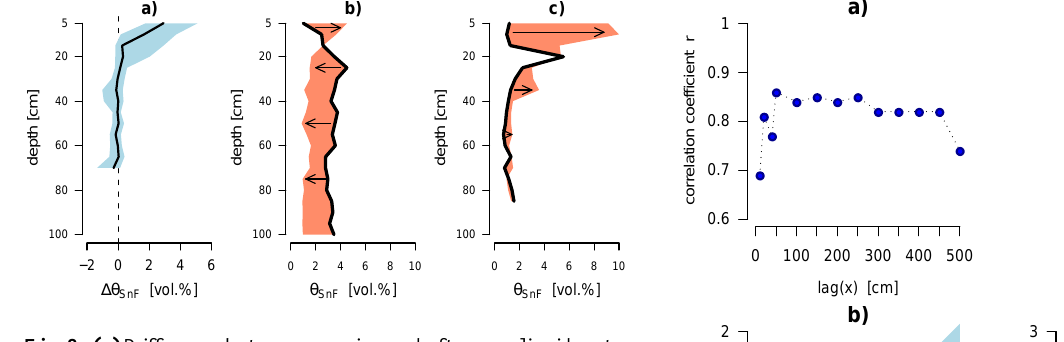
Fig. 10. State of snow wetness, 18 - 20 March 2010 on southerly aspect slopes at similar altitudes in the beginning of the melt phase. Contour plots showing cross-sections of snow wetness ( θ ) to a depth of up to 70 cm over 5 m wide areas across the slope. All observa- tions were observed in shallow snowpack areas at similar elevations (2000 - 2300 m) in southerly aspect slopes (SE, S, SW). θ , measured with the Snow Fork, is corrected by -0.8 vol.% (this corresponds to the median offset in dry snow). θ -values greater than 10 vol.% are shown as 10 vol.%.